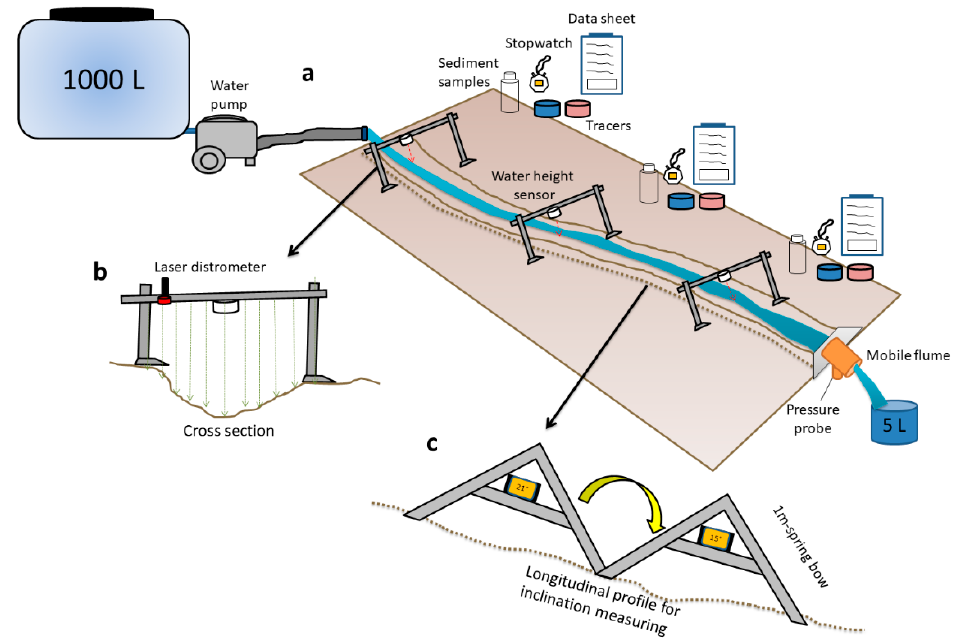
Figure 1. Runo ff experiment procedures: ( a ) rill experiment with the di ff erent measurement points; Figure 1. Runoff experiment procedures: ( a ) rill experiment with the different measurement points; ( b ) cross-section; ( c ) longitudinal profile ( b ) cross-section; ( c ) longitudinal profile measurements.